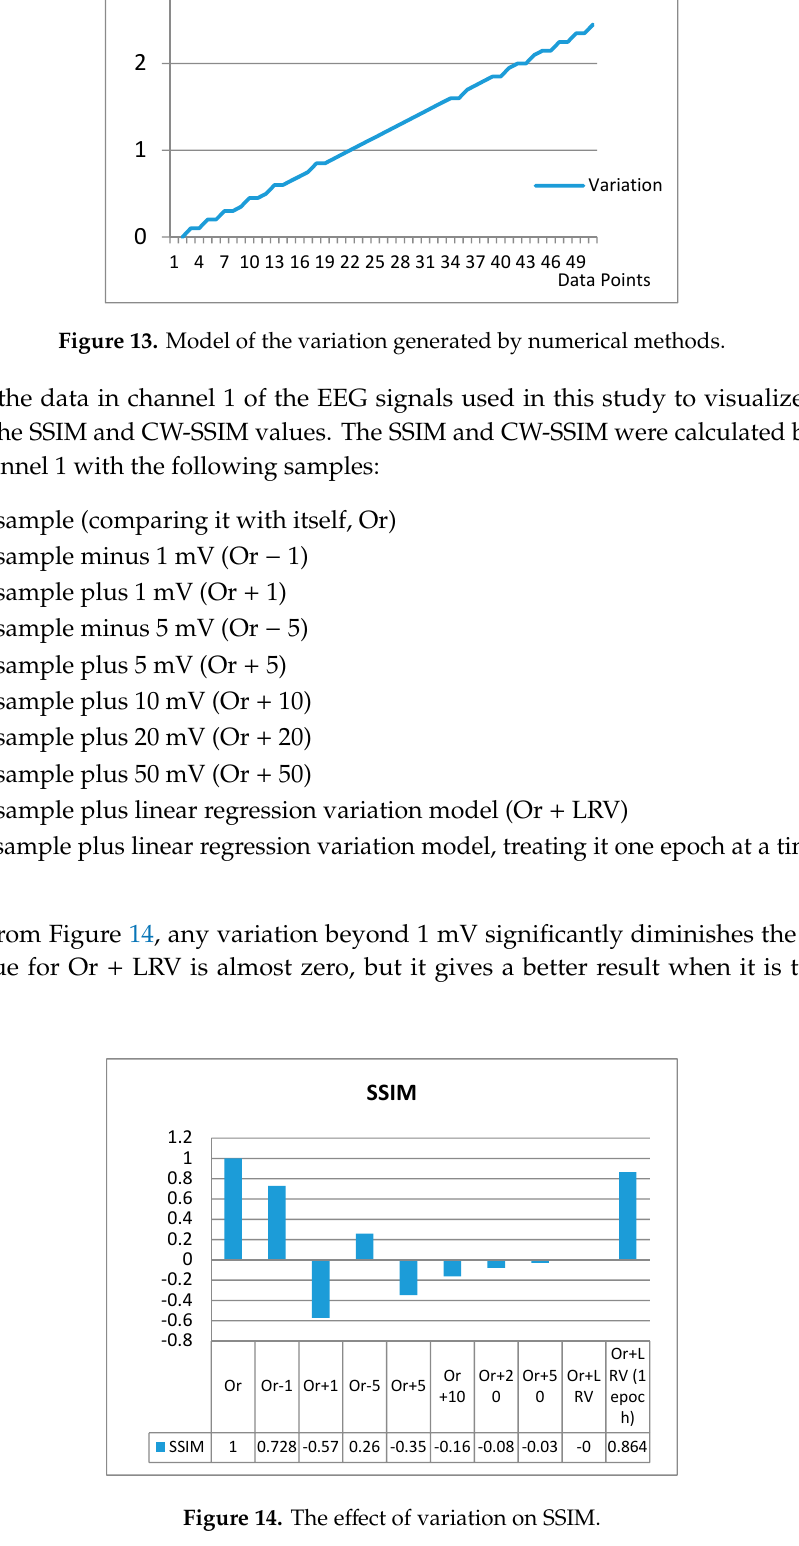
Figure 15. The effect of variation on CW-SSIM.